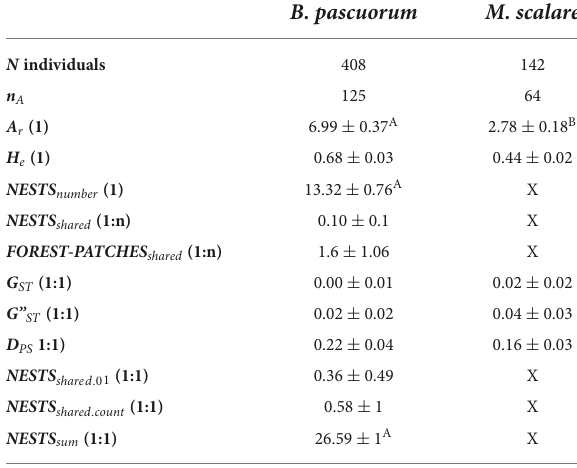
TABLE 4 Number (N) of sampled and genotyped pollinator individuals and number of alleles (n A ), mean and standard deviation of movement indicators within the forest patch: allelic richness (A r ), expected heterozygosity (H e ), NESTS number , NESTS shared , and FOREST-PATCHES shared ; movement indicators among the forest patches: G ST , G” T , D PS , pairwise NESTS shared . 01 , pairwise NESTS shared . count , and pairwise NESTS sum .